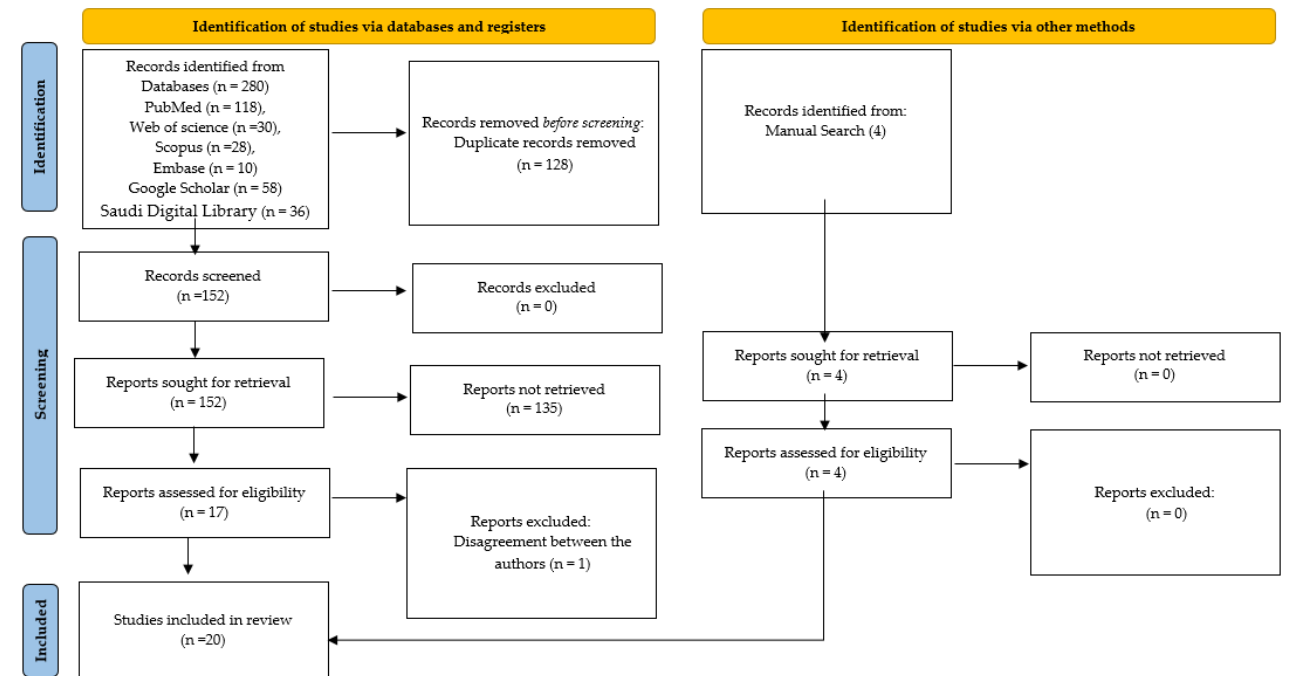
Figure 1. PRISMA flow chart for screening and selection of articles.